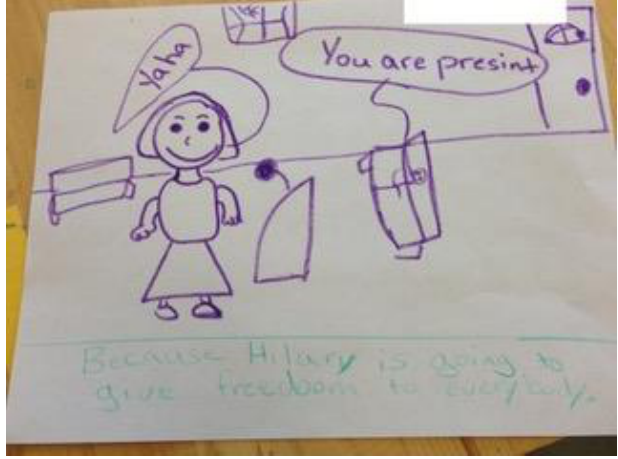
FIGURE 2. CHILD’S DEPICTION OF A PRESIDENTIAL ACCEPTANCE SPEECH BY THEN-CANDIDATE HILLARY CLINTON.